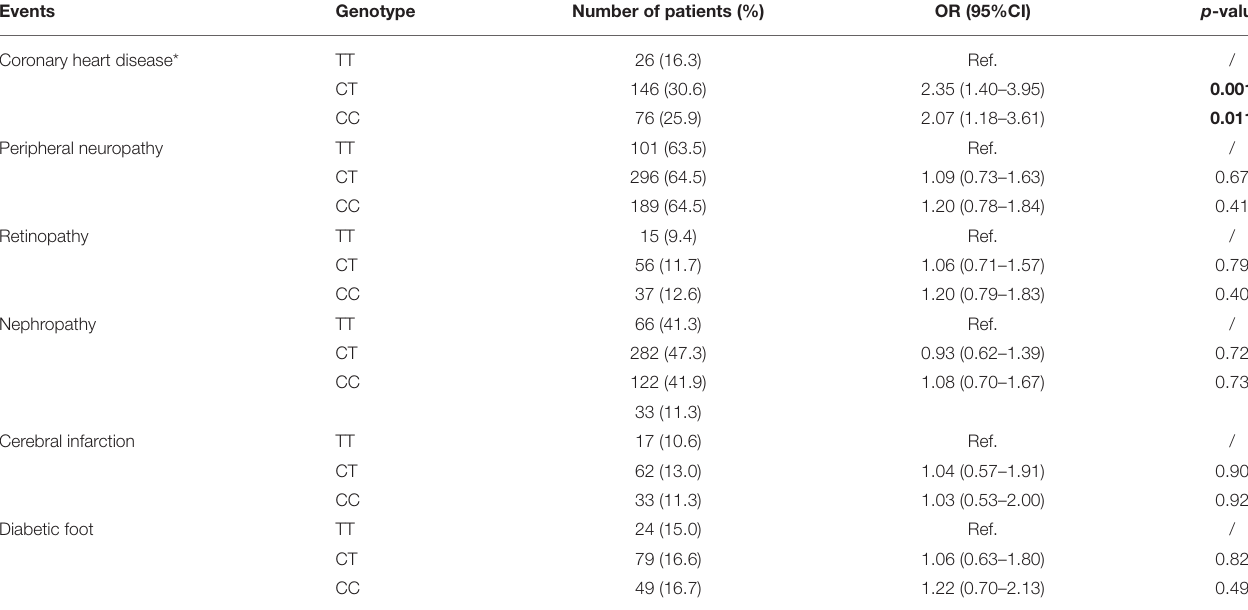
TABLE 2 | The association between GRB10 rs1800504 genetic variation and the risk of vascular complications in T2DM patients. Events